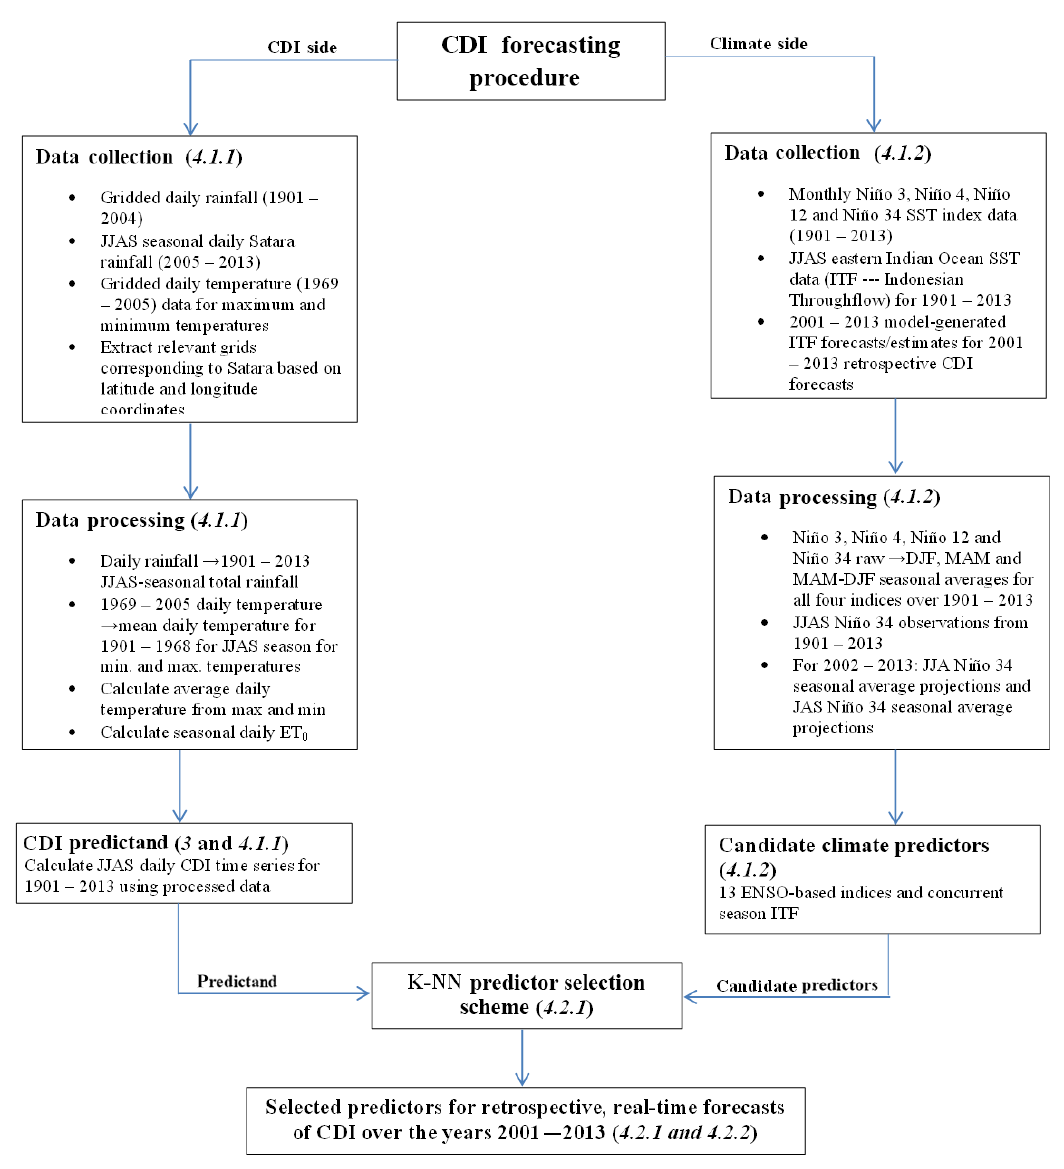
Figure 2. Flowchart depicting the entire forecasting procedure for potato-based CDI in Satara, Maharashtra, India. The steps are categorized as data collection, data processing, predictand/predictor calculation, all of which converge to predictor selection and forecast modeling. The section number of the paper in which these steps are covered is written in italics next to the category. A brief summary of each step is given, one for the steps used in CDI calculation and another for the steps used in processing the candidate predictors from